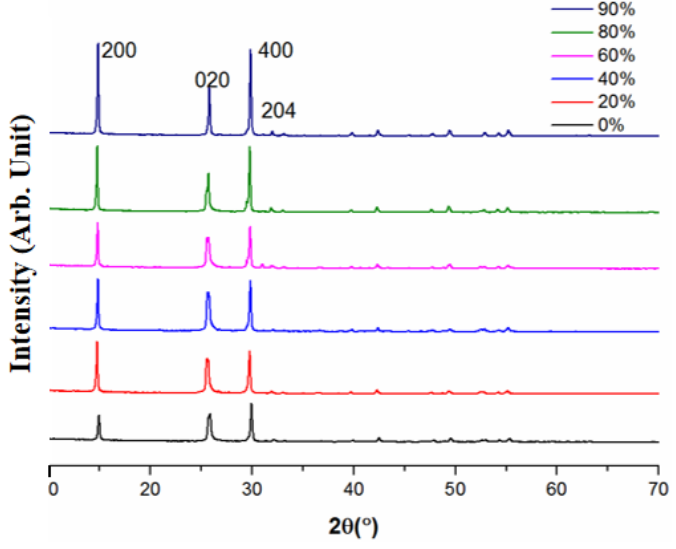
Figure 15. The XRD patterns of samples prepared in different glycerol